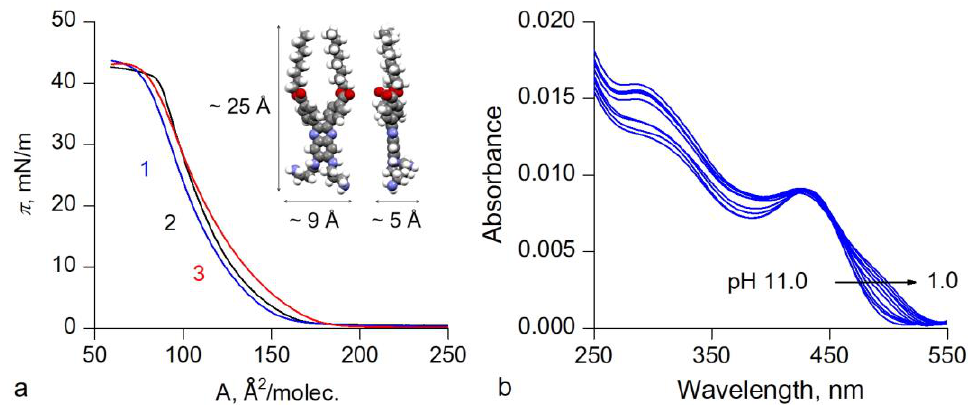
Figure 5. ( a ) Surface pressure vs. area isotherms of QC8 on the deionized water surface at pH 11.0 ( 1 ), 5.5 ( 2 ), and 1.0 ( 3 ). Insert shows spacefill model of QC8 molecule optimized by the